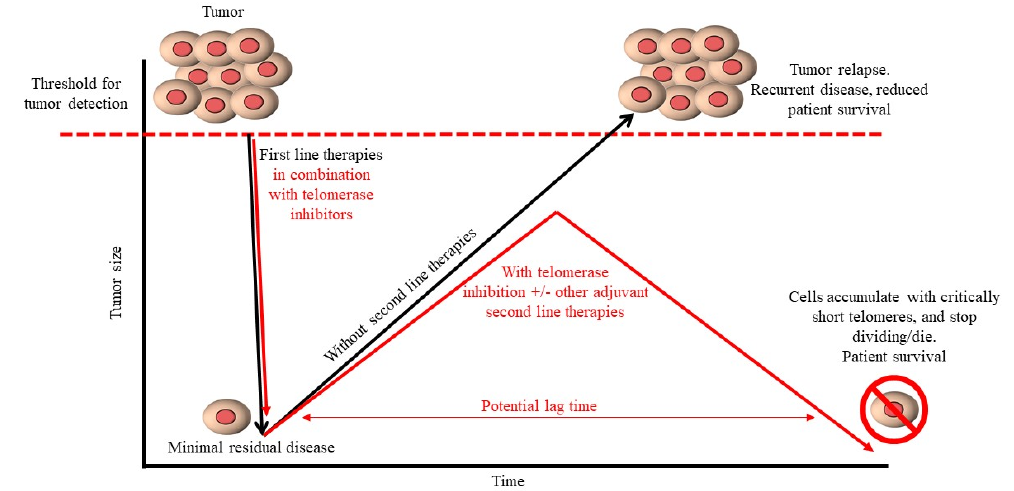
Figure 4. Potential use of telomerase inhibitors as cancer therapeutics. First line-therapies (surgery, radiation, and chemotherapy) aim to minimize residue levels of cancerous cells. However, there is risk associated with residual cancerous cells remaining viable and possessing the capacity for continued replication due to various mechanisms, including retaining telomerase activity and telomere length maintenance mechanisms. As a result, tumors may reoccur and reduce patient survival rates. The use of telomerase inhibitors simultaneously with first line therapies or as a second line therapy may help to prevent regrowth of remaining tumor cells by shortening telomeres to critically shortened